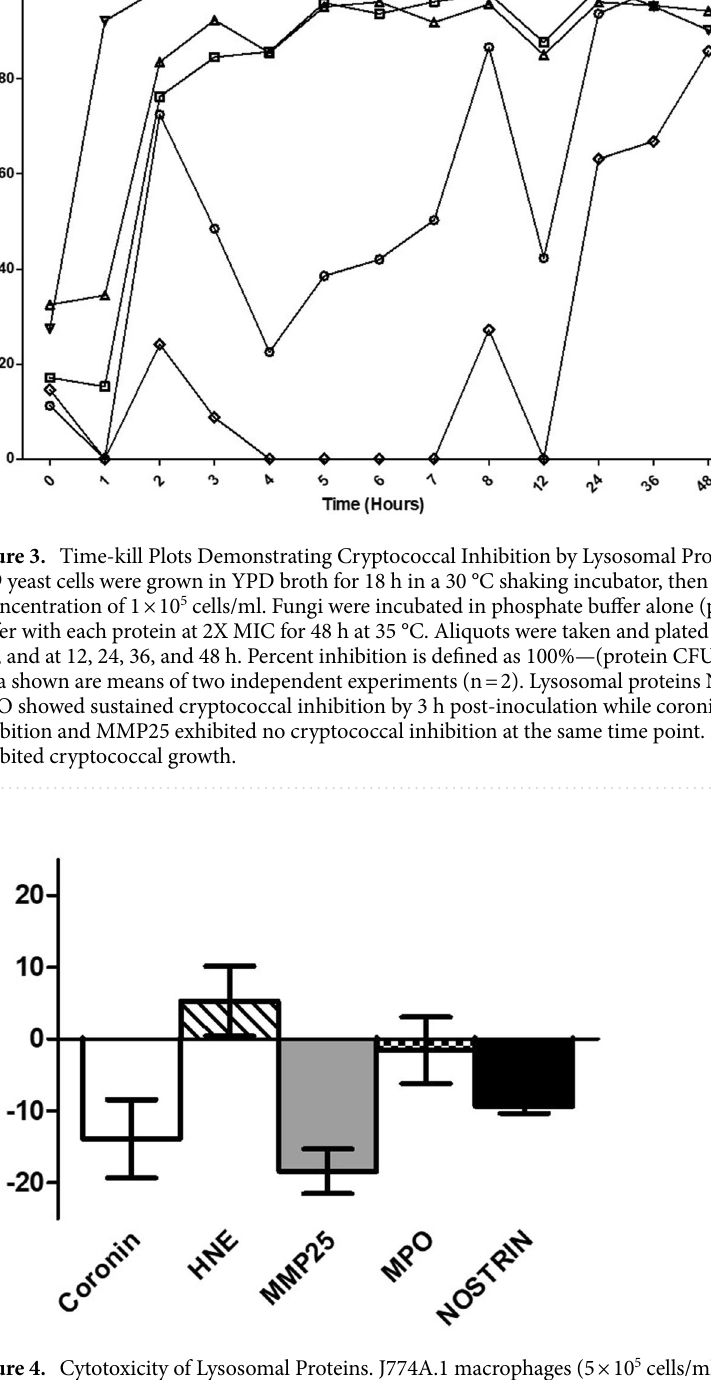
kill the pathogen 26 . Due to the problems associated with current anti-cryptococcal drug therapies, finding new sources of treatment has become a major area of research.